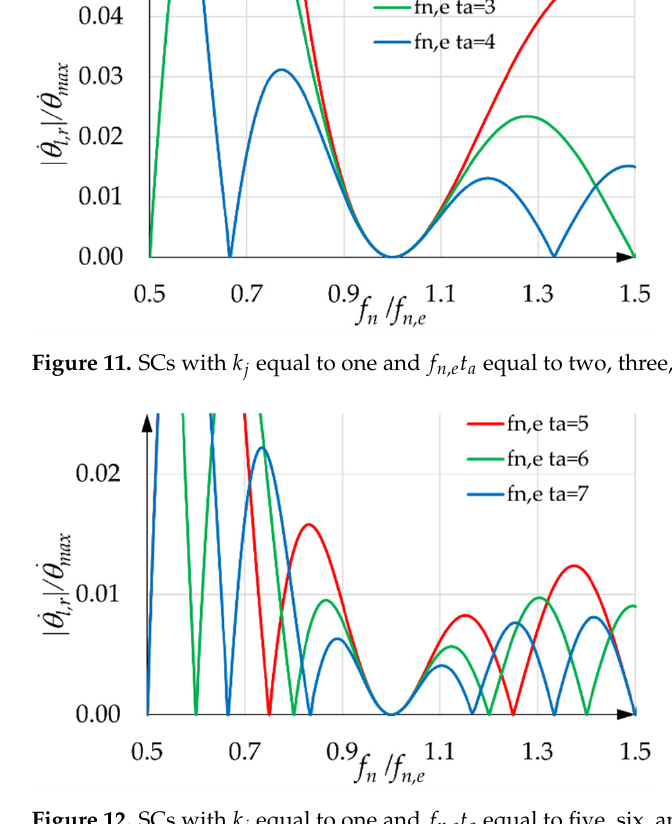
k equal to one and j